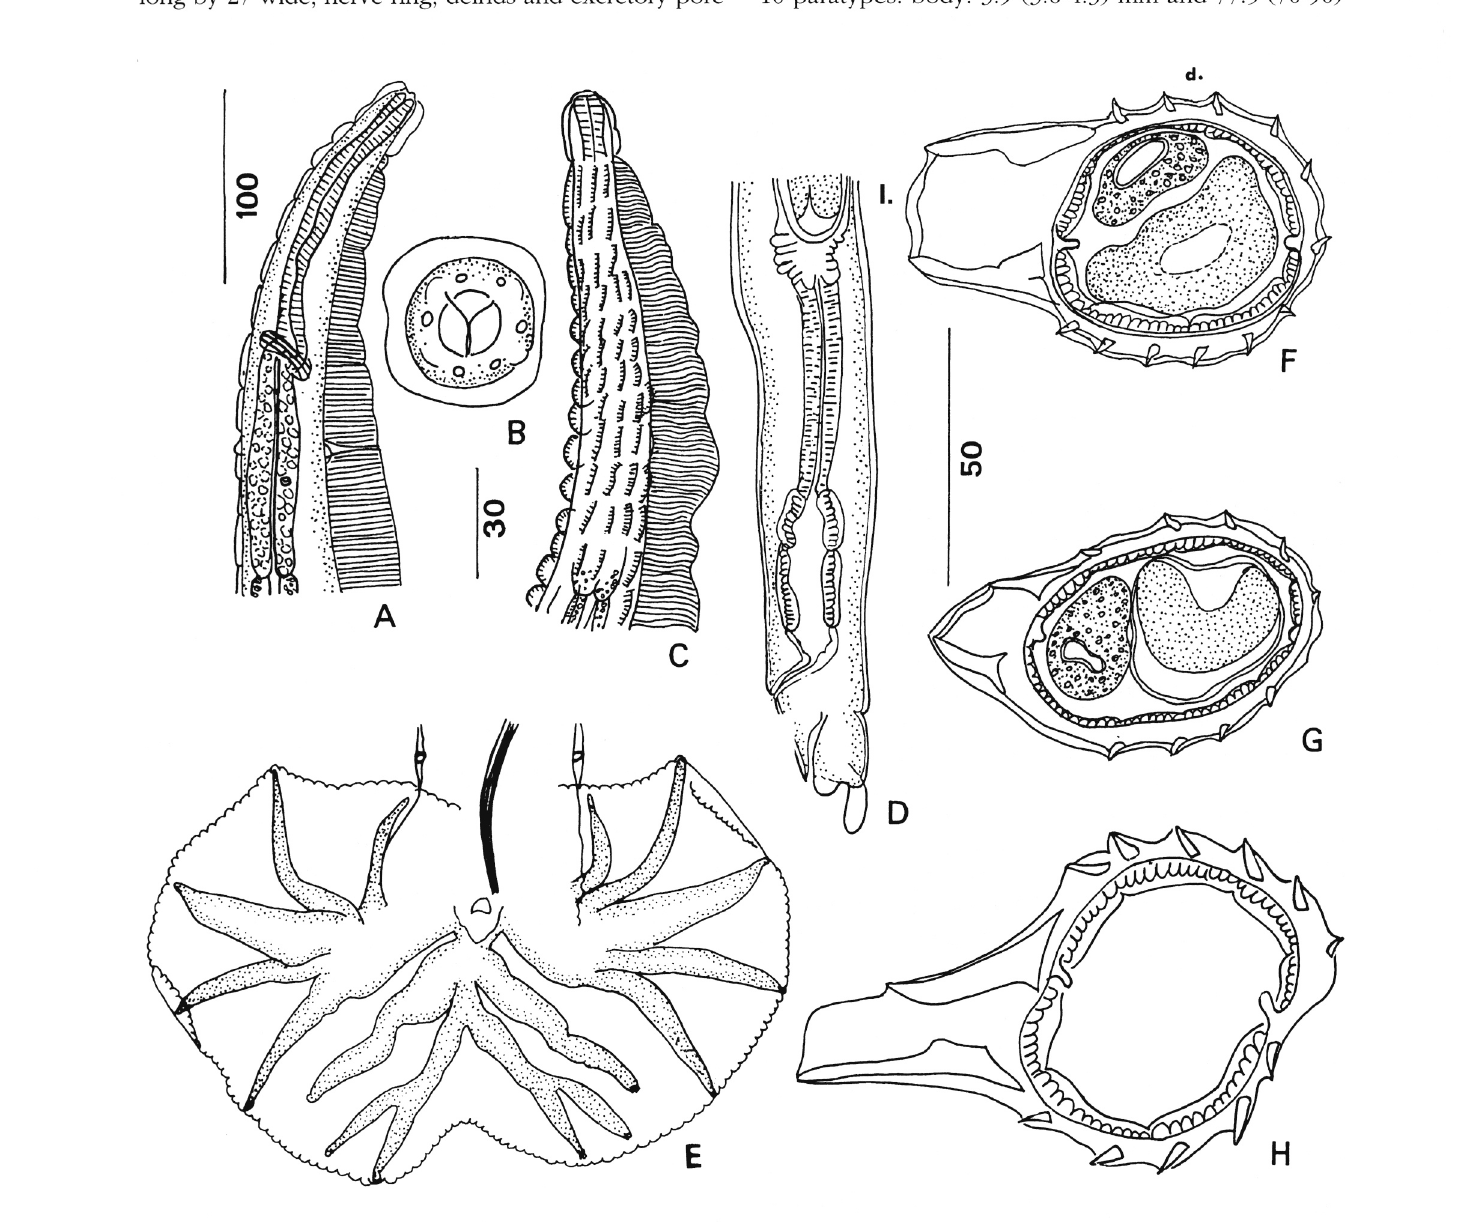
Fig. 4. - Heligmostrongylus chiarae n. sp. A, male, anterior extremity, ventral view. B, male, head, apical view. C, male, anterior extremity with cuticular ridges interrupted and arranged in linear series, ventral view. D, female, ovejector and tail, left lateral view. E, male, caudal bursa, ventral view. F-H, transverse sections of the body. F, G, female. F, at mid-body. G, at level of the uterus. H, male, at mid-body. All the sections are orientated as F. Abbreviations: l: left side, d: dorsal side. Scale: A, C, D: 100 μ m; B, E: 30 μ m; F-H: 50 μ